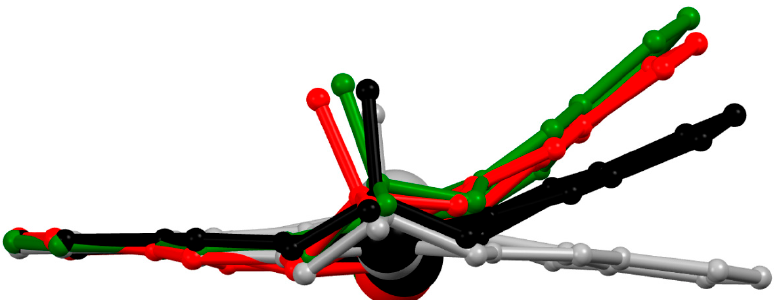
Figure 3. Overlay of selected molecular fragments of coordination units in complexes of 1 (red), 2 (black), 3 (grey) and a previously reported complex of H 4 L with Cu II –Nd III –Cu II (green) [15]. The superposition was made for the benzene